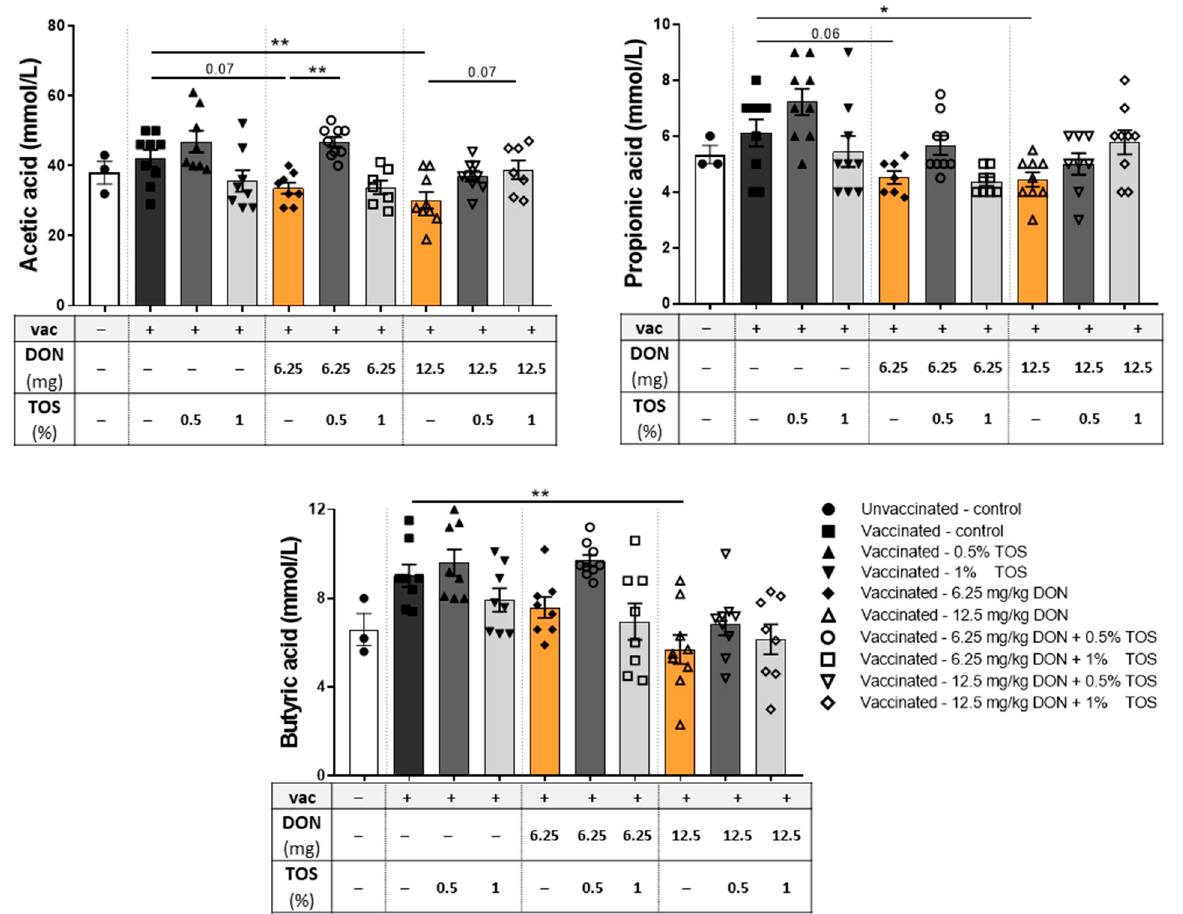
Figure 9. Short-chain fatty acid (SCFA) concentrations in the cecum of vaccinated (vac +) and unvaccinated (vac − ) mice fed on diets containing deoxynivalenol (DON) and/or trans-galacto-oligosaccharides (TOS). The concentrations of acetic, propionic and butyric acids were evident in the clear supernatants of cecum contents. Data are presented as mean ± SEM. * p < 0.05 and ** p < 0.01 indicate statistical differences.